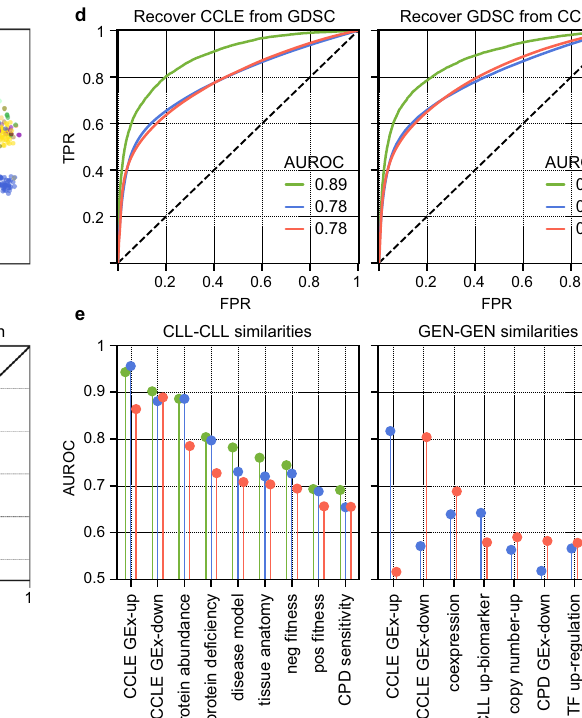
embeddings (x-axis). d Recovering CCLE (left) and GDSC (right) cell-cell (CLL-CLL) similarities (green), cell-gene (CLL-GEN) upregulation (upr) similarities (blue) and CLL-GEN downregulation (dwr) similarities (red) using embedding distances from the GDSC and the CCLE embedding spaces, respectively. e Characterization of the CLL-CLL (left) and GEN – GEN (right) embedding similarities for three metapaths: CLL-gex-CLL (green), CLL-upr-GEN (blue) and CLL-dwr-GEN